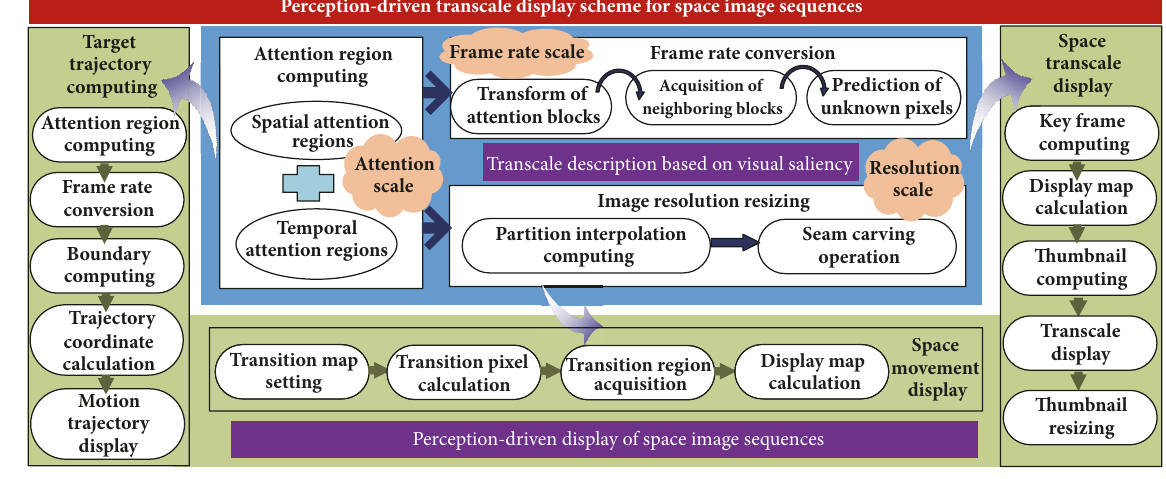
Figure 1: The framework of